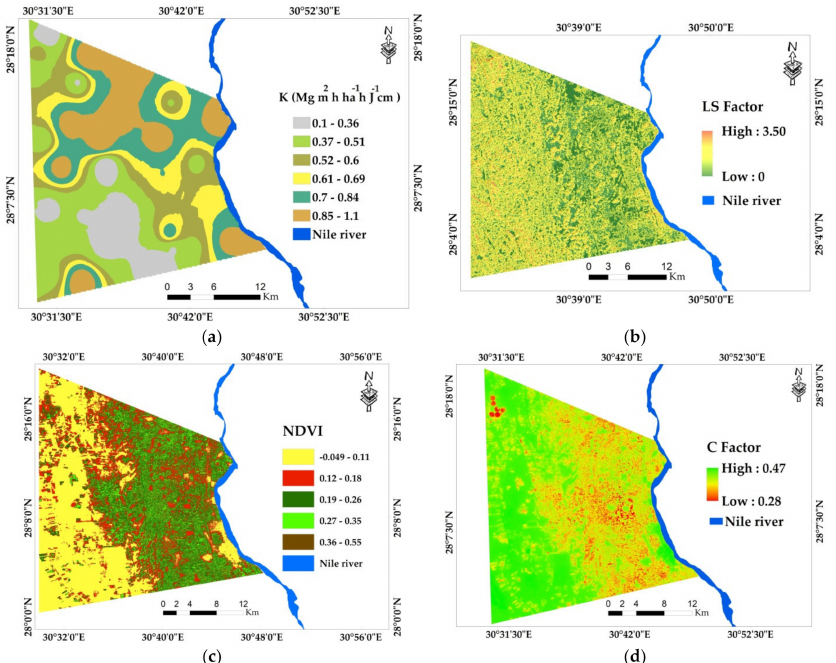
Figure 8. Spatial distribution of ( a ) k factor (t ha − 1 y − 1 ), ( b ) LS factor, ( c ) NDVI, and ( d ) C